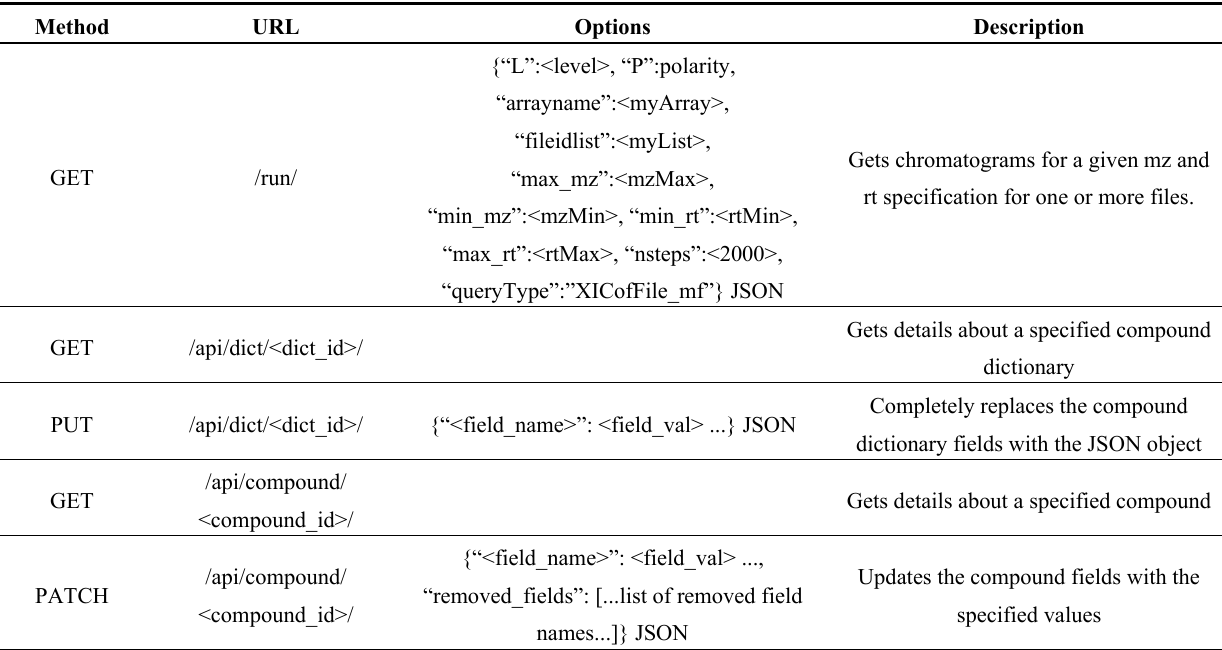
Table 1. Integrated metabolite atlas API for simultaneously querying raw data along with compound